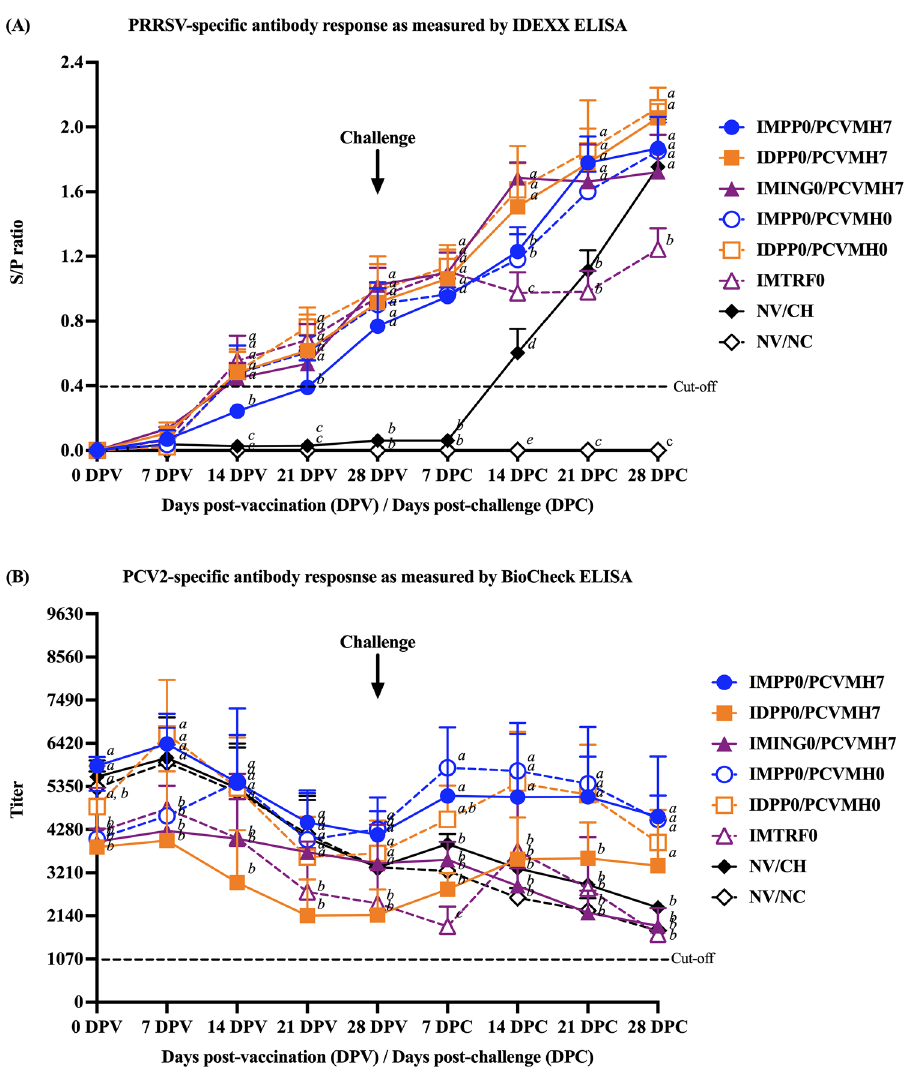
Figure 2. Mean values of ( A ) PRRSV-specific antibody response and ( B ) PCV2-specific antibody response as measured by ELISA. Values expressed as mean ± SEM. ( A ) Sample-to-positive (S/P) ratios equal to or greater than 0.4 were considered positive (cut-off value, dashed-line). ( B ) PCV2-specific titers equal to or greater than 1070 were considered positive (cut-off value, dashed-line). The results were compared using two-way ANOVA for multiple comparisons. Different lowercase letters (a–c) indicate significant differences between treatment groups ( p < 0.05) for each